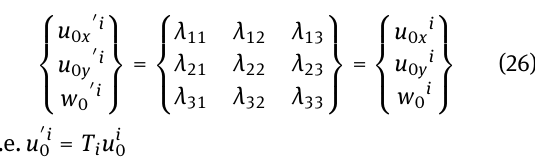
where λ , λ , . . . etc. are the direction cosines of the local 11 12 axes with respect to global axes. The direction cosines are calculated as given in [50]. The local DOF are shown with primed and the global DOF are shown with-out primed. The relationship between the local rotations and global rotations for i th node is given by the following expression.